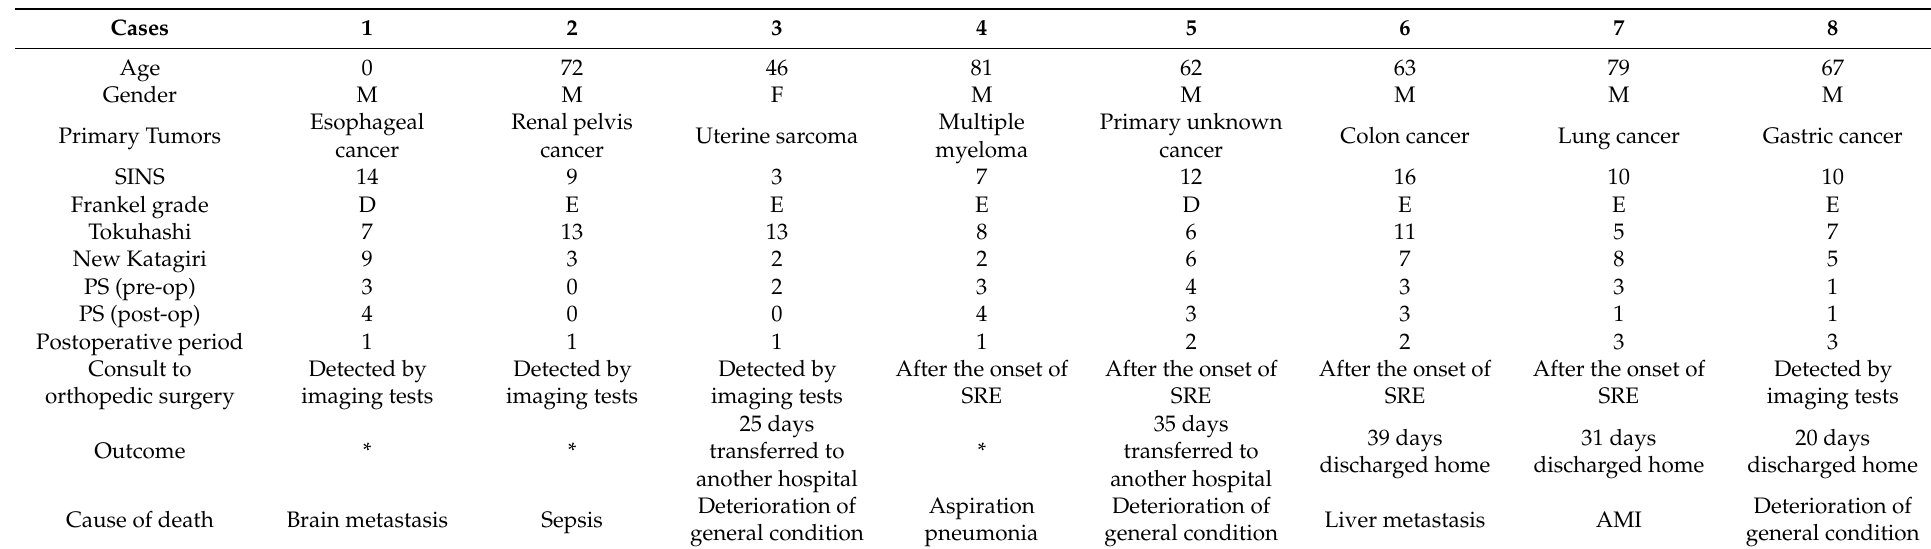
Table 5. Cases of early